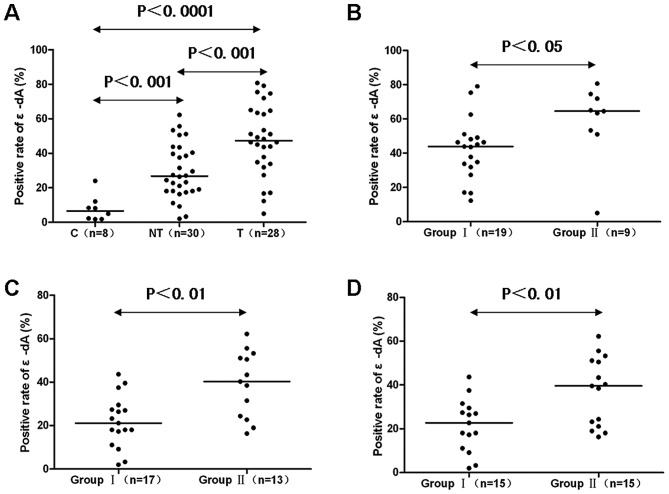
Comparison of ɛ-dA prevalence in liver tissues. (A) ɛ-dA prevalence in T was greater than in NT, and it was greater in NT compared to C. (B) The ɛ-dA prevalence in group II (moderately-poorly and poorly differentiated) HCC was greater than in group I (well, well-moderately and moderately differentiated) HCC. (C) Based on necroinflammatory activity, the positive rate of ɛ-dA in group II (moderate and severe chronic hepatitis) was higher than in group I (minimal and mild chronic hepatitis) NT. (D) Based on fibrosis degree, the positive rate of ɛ-dA in group II (severe fibrosis and cirrhosis) was higher than in group I (none and mild and moderate fibrosis) NT. C, control liver tissue; NT, non-tumor liver tissue; T, HCC tissue. Black line represents median.